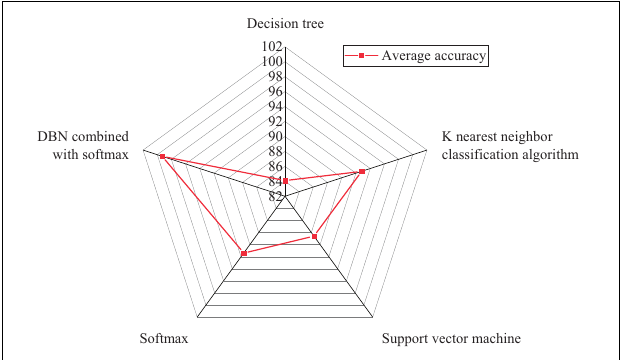
FIGURE 9 | The average accuracy of the discrimination algorithm based on the DBN and traditional discriminator for national musical instrument recognition.